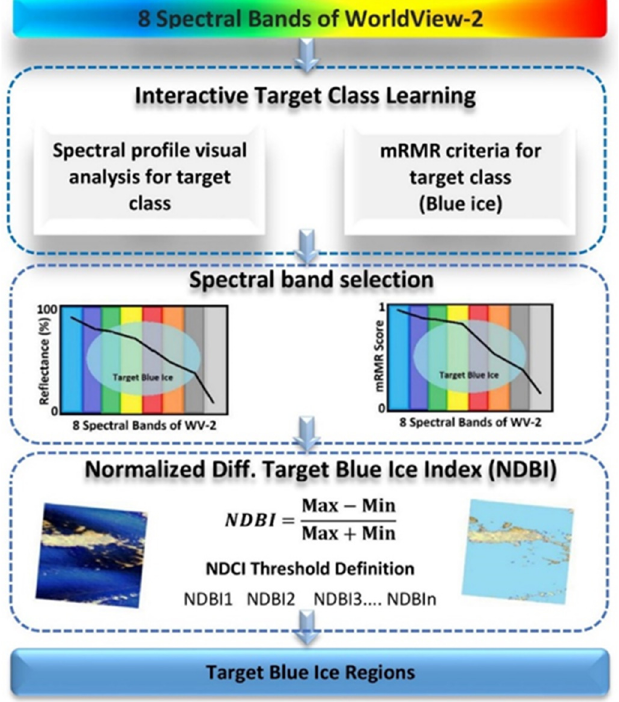
Figure 4. Workflow for generating a customized Normalized Difference Blue Ice Index (NDBI). The reflectance values for blue, coastal, green, and yellow bands are comparable for most of the profiles. The maximum reflectance rendered by these four bands can be used to identify the blue ice on the image. The customized NDBIs proposed for establishing effective blue ice mapping methods using WV-2 images are listed in Table 3. Sample spectral profiles (Supplementary Figure S4) of blue ice reveal that coastal, blue, yellow, and green bands have maximum mRMR score for blue ice and can be explored for customizing